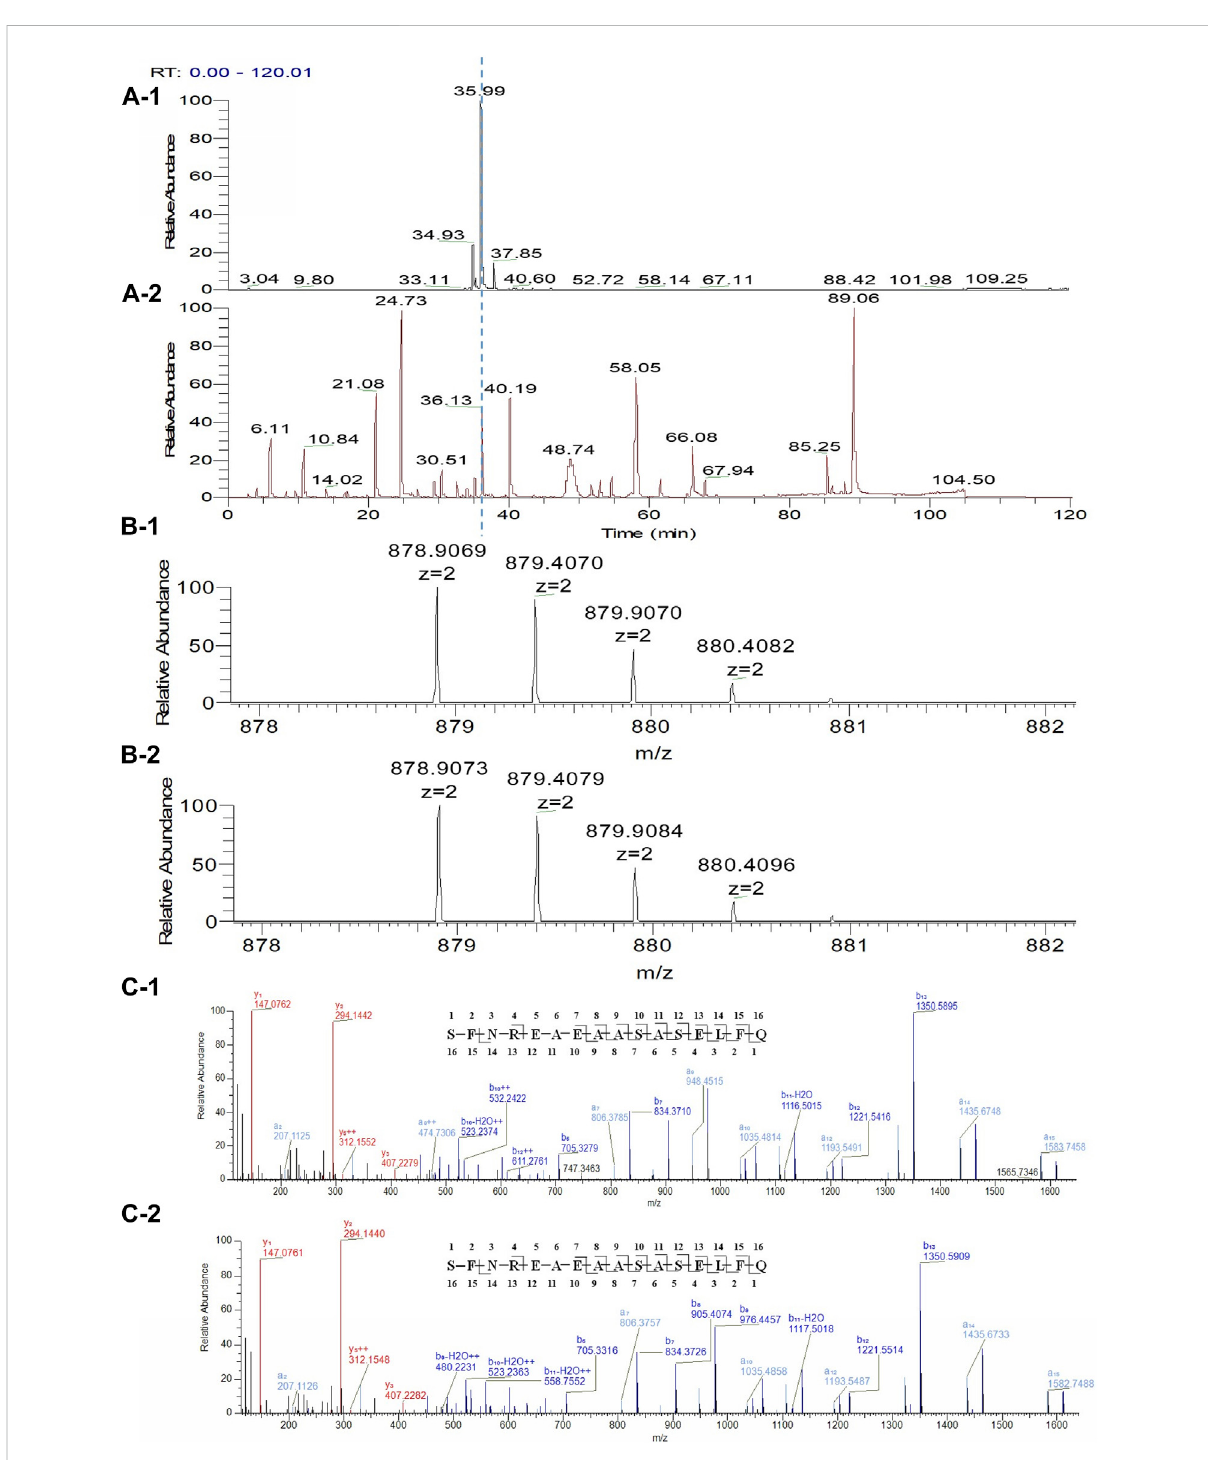
FIGURE 5 LC C-terminal extension con fi rm by comparing with synthetic peptide. (A-1) : Reduced Lys-C peptide mapping TIC of Fraction-2; (A-2) : Reduced Lys-C peptide mapping TIC of the synthetic peptide (SFNREAEAASASELFQ); (B-1) : MS pro fi le of the Peptide 1 from Fraction-2; (B-2) : MS pro fi le of the synthetic peptide (SFNREAEAASASELFQ); (C-1) : MS/MS pro fi le of the Peptide 1 from Fraction-2; (C-2) : MS/MS pro fi le of the synthetic peptide